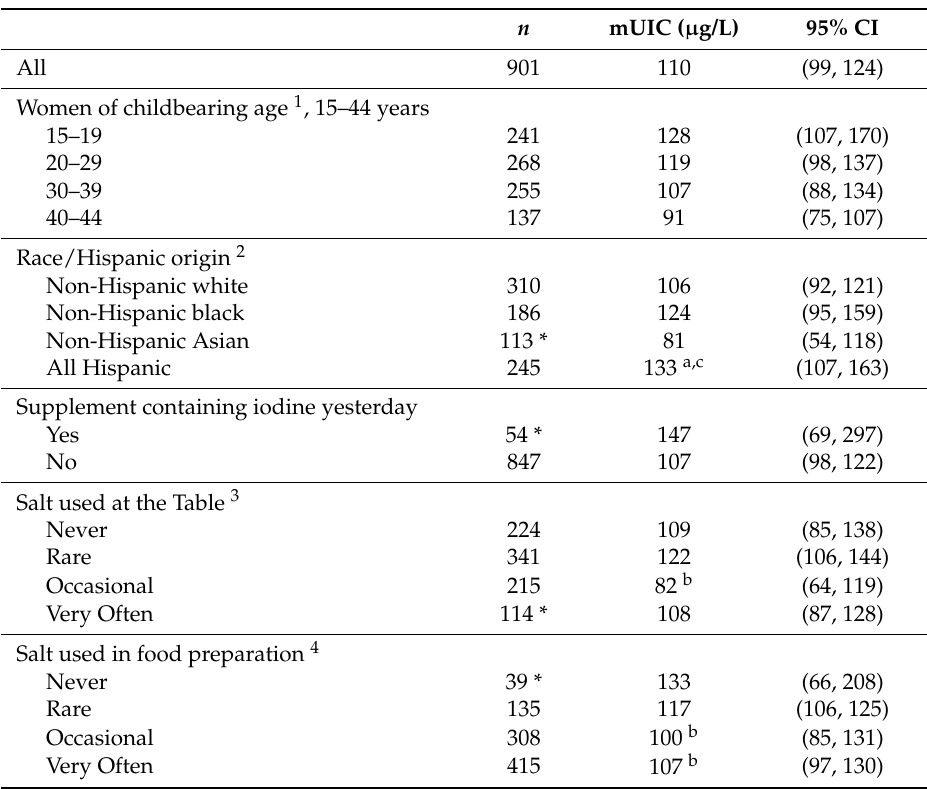
Table 2. Median UIC (ug/L) of women 15–44 years, by demographic and lifestyle characteristics, NHANES 2011–2014.